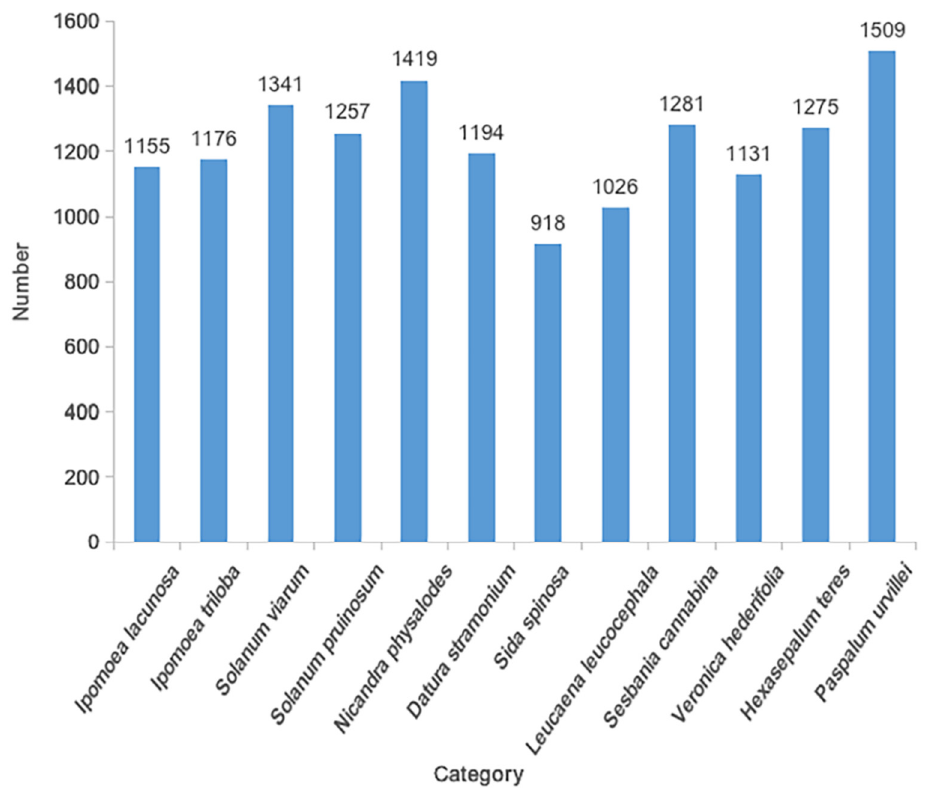
Figure 13. Target number statistics of each category in data set, the number of occurrences of the target seed in the data set.